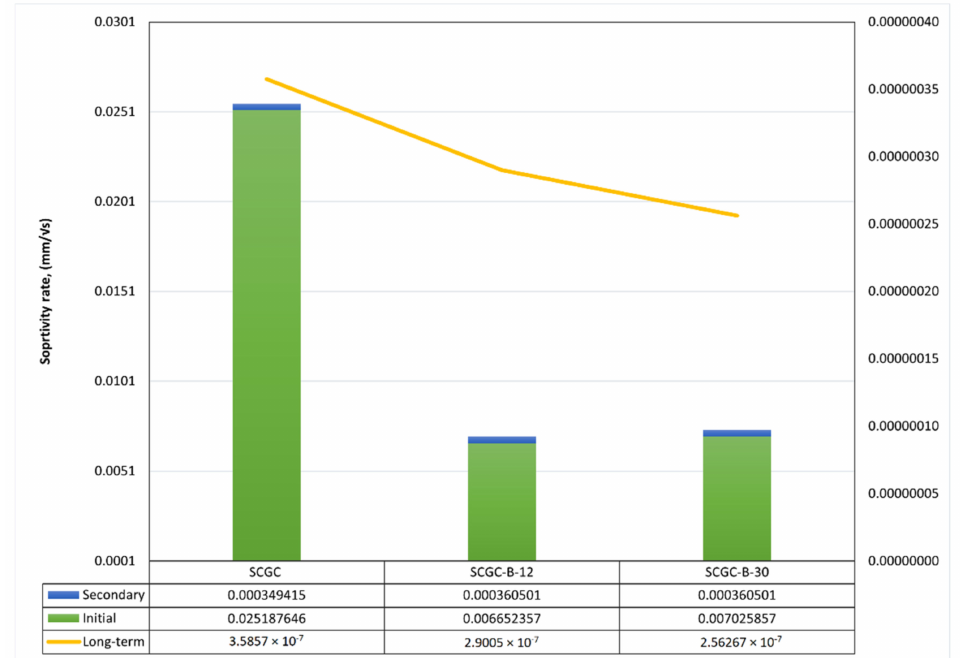
Figure 13. Sorptivity of SCGC, SCGC with 12 mm basalt fibres and 30 mm basalt